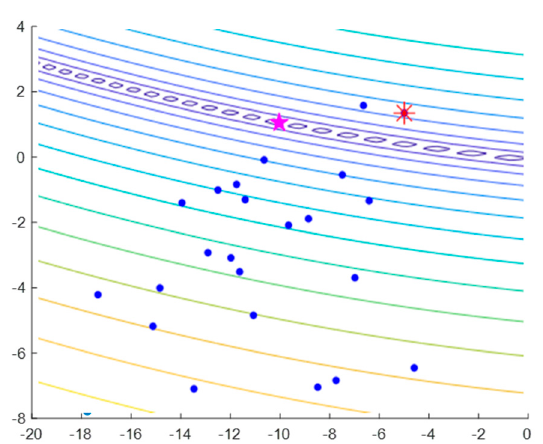
Figure 4. The random number distribution of the population after the first iteration.